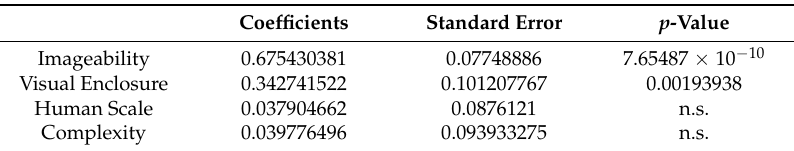
Table 5. Regression statistics of the SOP